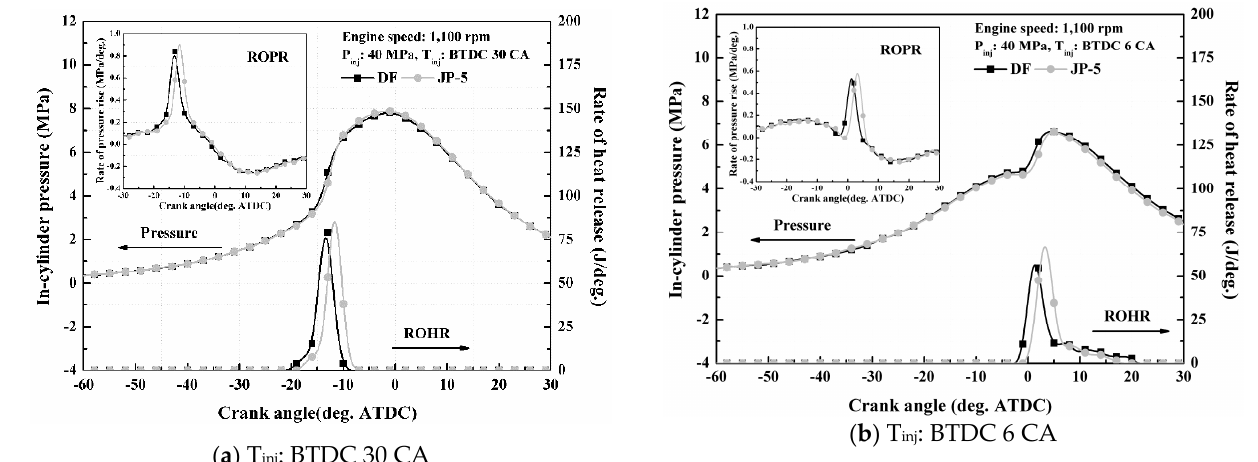
Figure 4. In-cylinder pressure, ROHR, and ROPR characteristics with the injection timings.